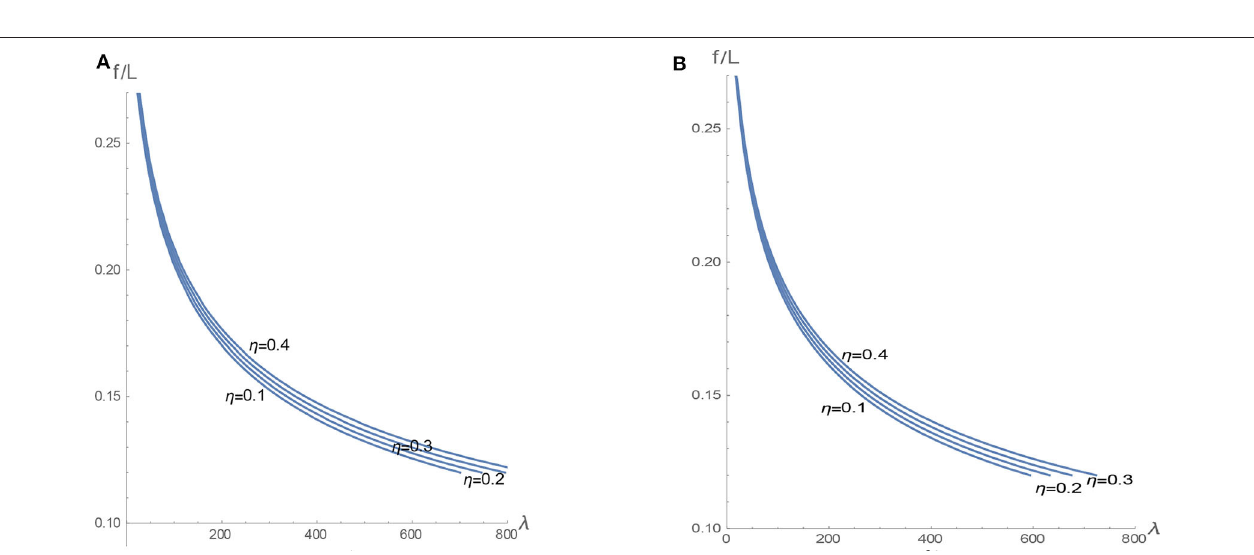
FIGURE 5 | Dimensionless volume f d V / qL 2 versus the rise/span ratio f / L for λ = 200: (A) k = 0, (B) k = 10, (C) k = 50, and (D) k = 500.